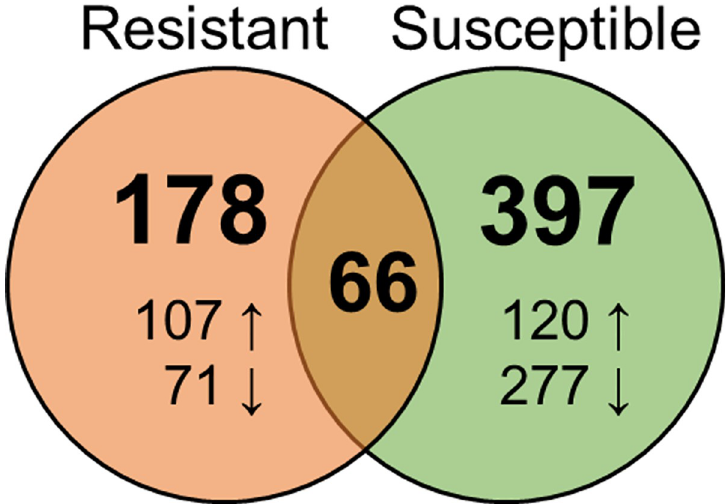
Fig 4. Venn Diagram showing the number of genes differentially expressed in response to Ceratonova shasta infection in the gills of resistant and susceptible steelhead at 1 day post exposure. Arrows indicate upregulation vs